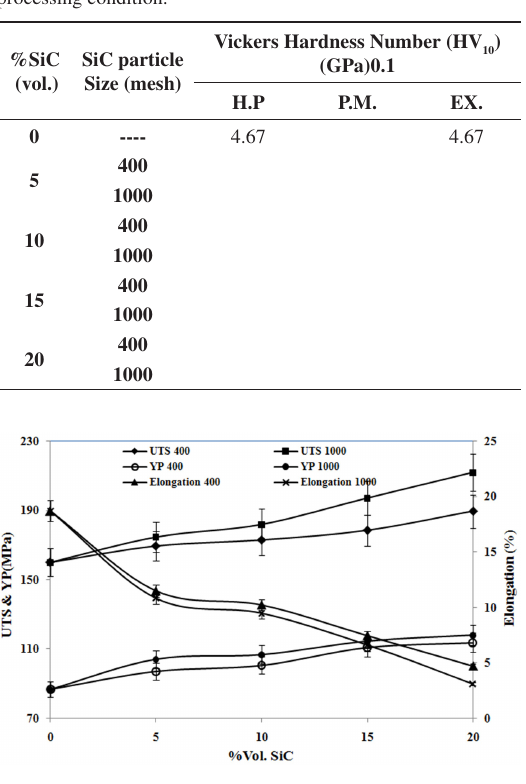
Figure 4. Ultimate tensile strength, yielding point and elongation from tensile experiments of hot extruded Al-SiC composites.